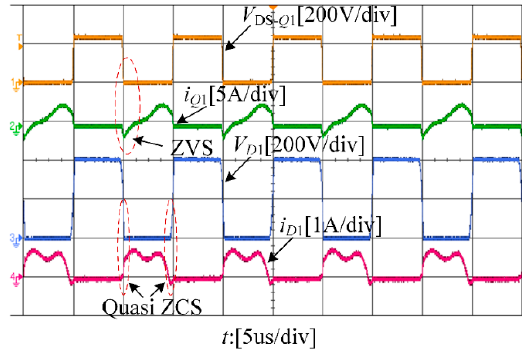
Figure 14. Experimental waveforms at the rated point.